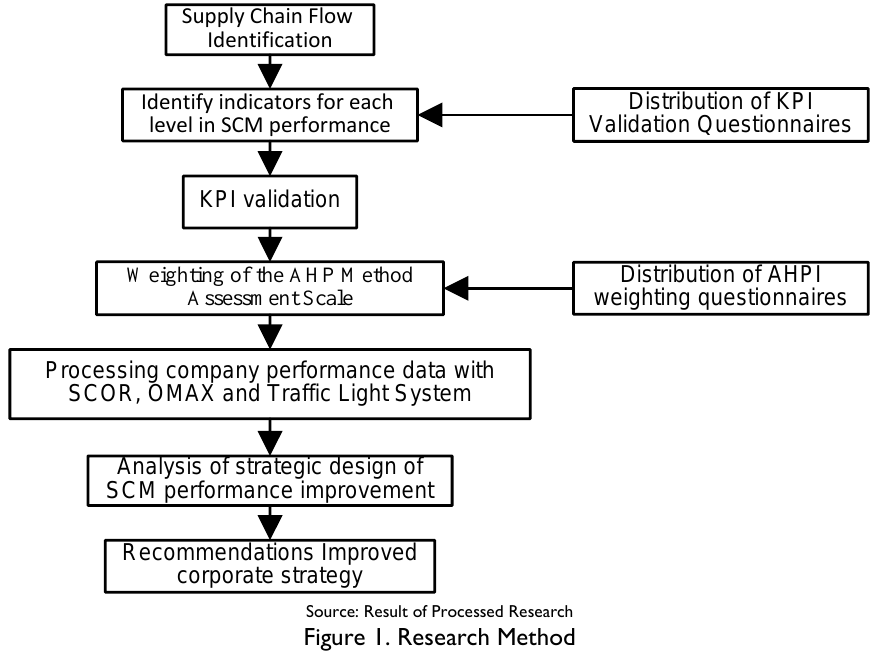
Figure 1. Research